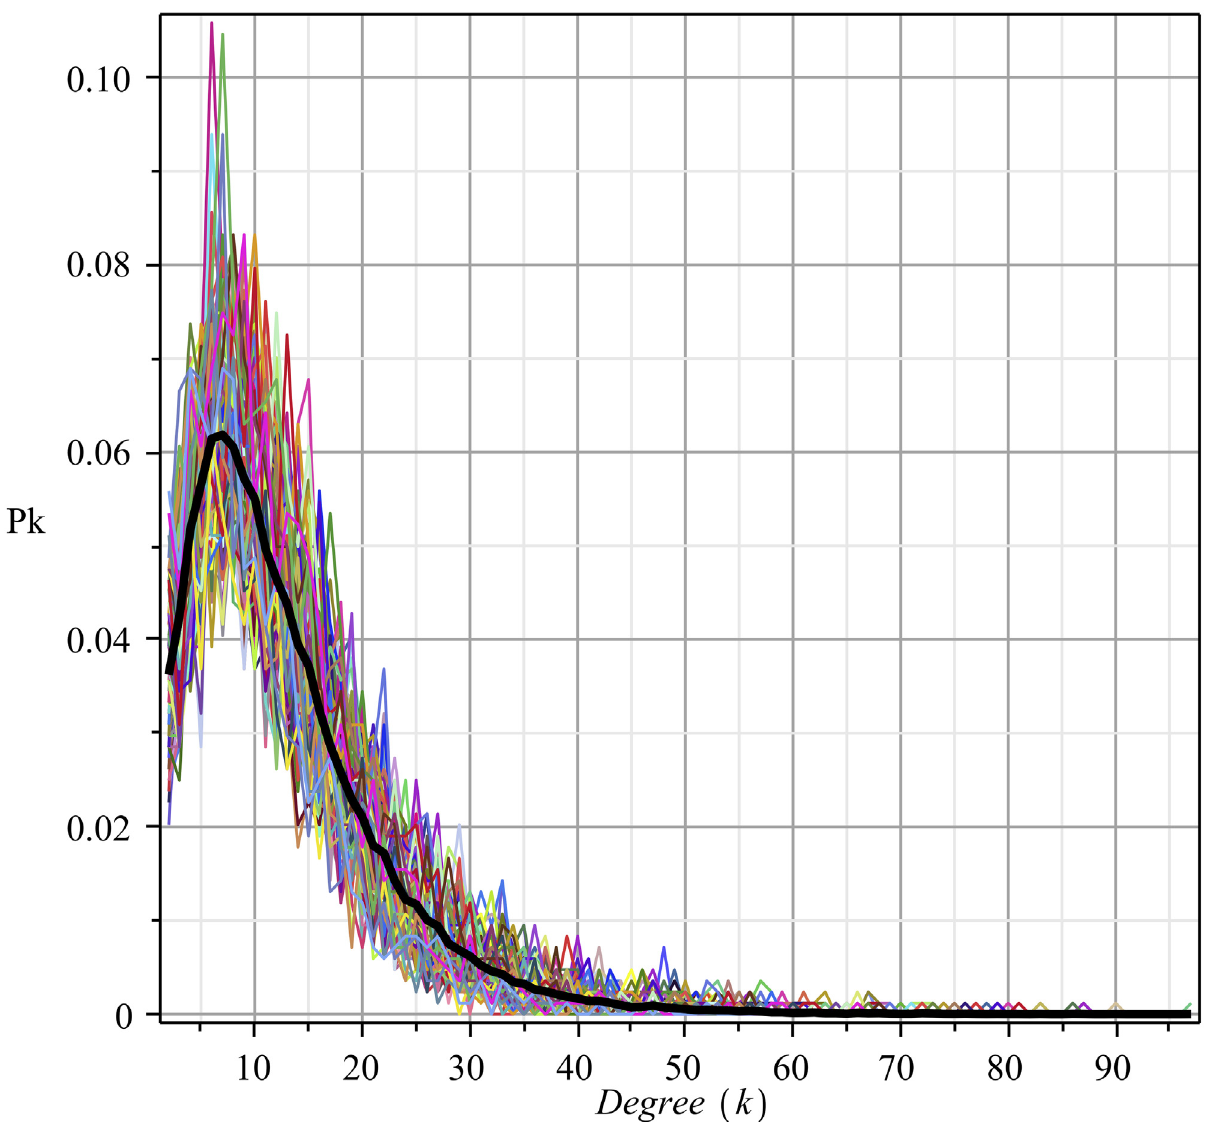
Fig 3. Degree probability function of the social network over time. The average probability distribution function (PDF) is in black. This PDF came from fitting by Pk * k a e − bk . The coefficients (95% confidence bounds) are as follows: a = 0.8199(0.7873, 0.8525), b = 0.1548(0.1506, 0.1589); goodness of fit (SSE) = 0.777 × 10 − 4 ; R-square = .9975, adjusted R-square = .9975, RMSE = 0.9141 × 10 − 3